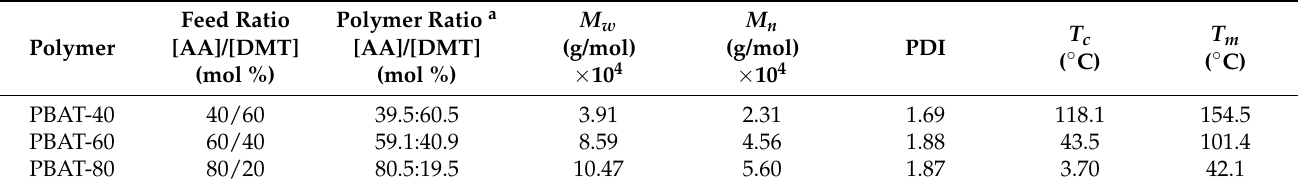
Figure 1. The reaction scheme of synthesis and grafted interaction of PBAT. Table 1. The synthesized polymer ratio, molecular weight, and crystallization temperatures of fabricated copolyesters.